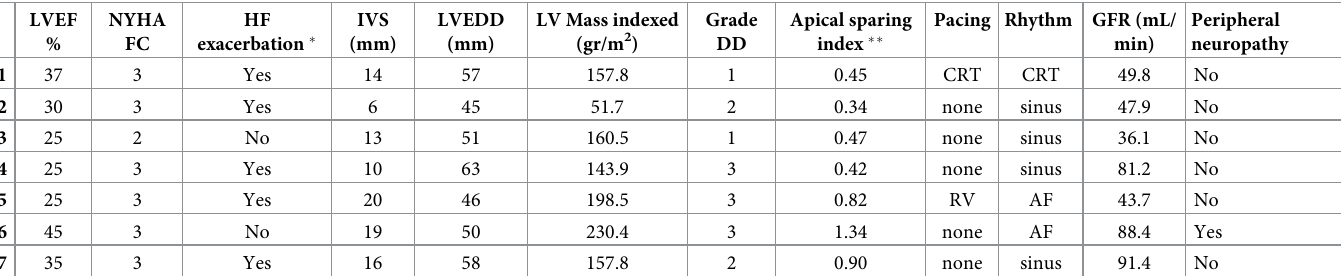
The individual clinical and echocardiographic features of patients with ATTR-CA.